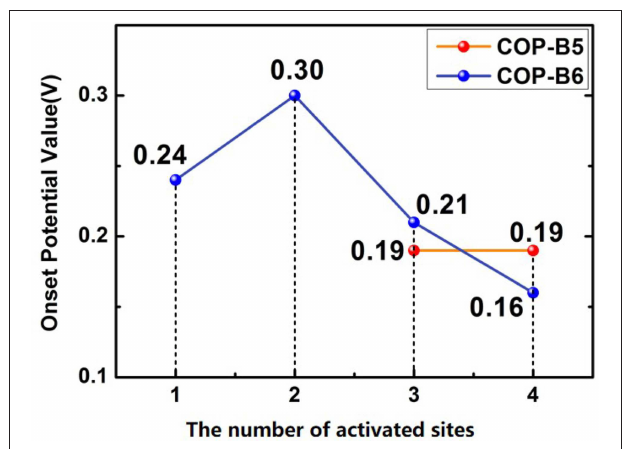
FIGURE 6 | The number of activated sites and the corresponding onset potential values for ORR. The possible ORR sites were marked in Figure S2